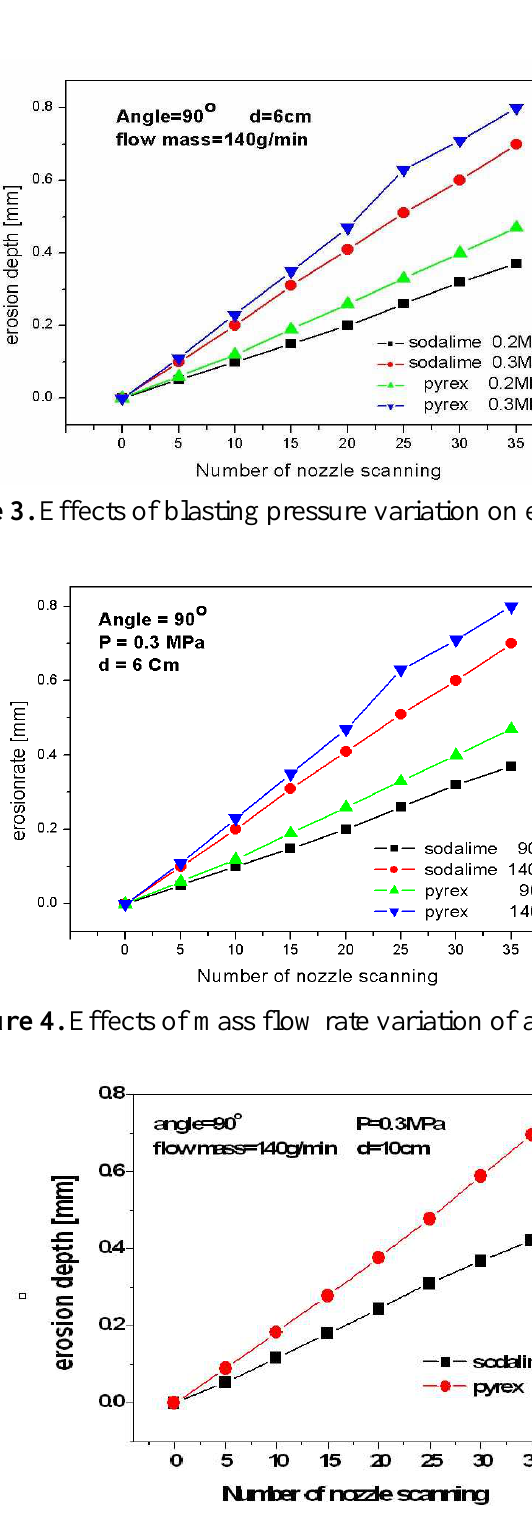
Figure 5. Comparison of erosion depth of the Pyrex and the soda lime